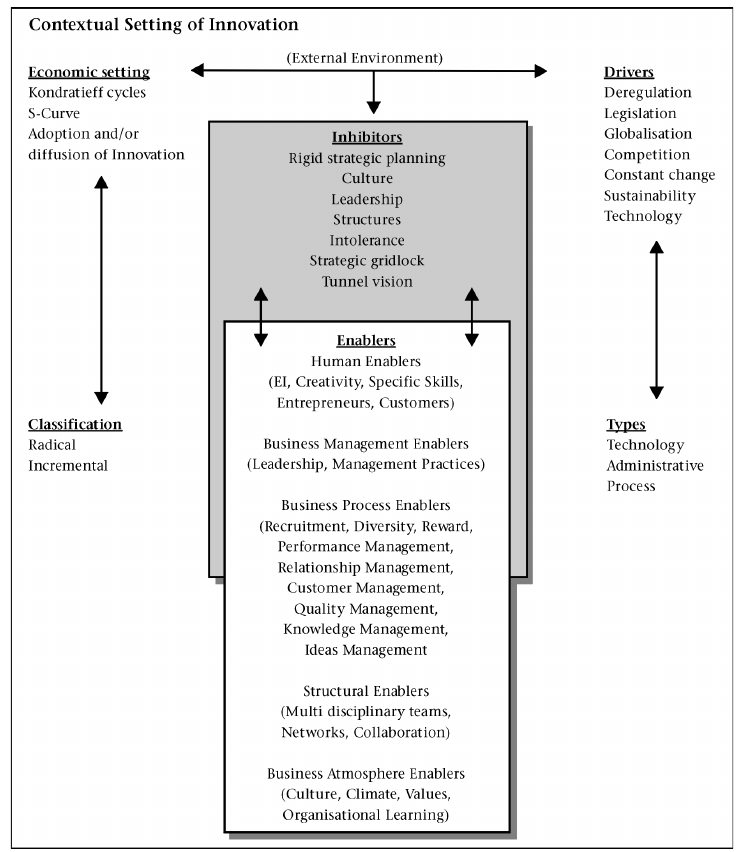
Figure 3: Proposed framework of innovation based on a literature